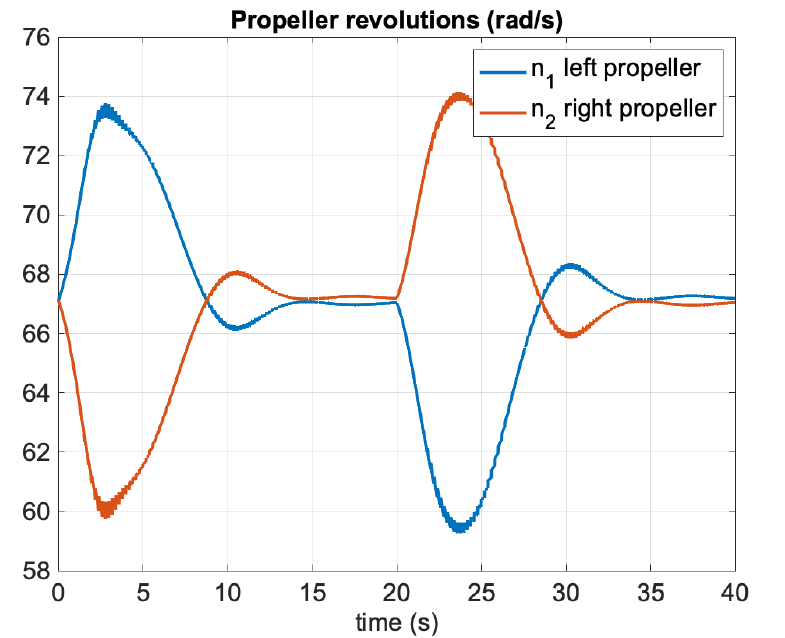
Figure 5. Simulation study: Propeller revolutions n 1 and n 2 versus time during autopilot